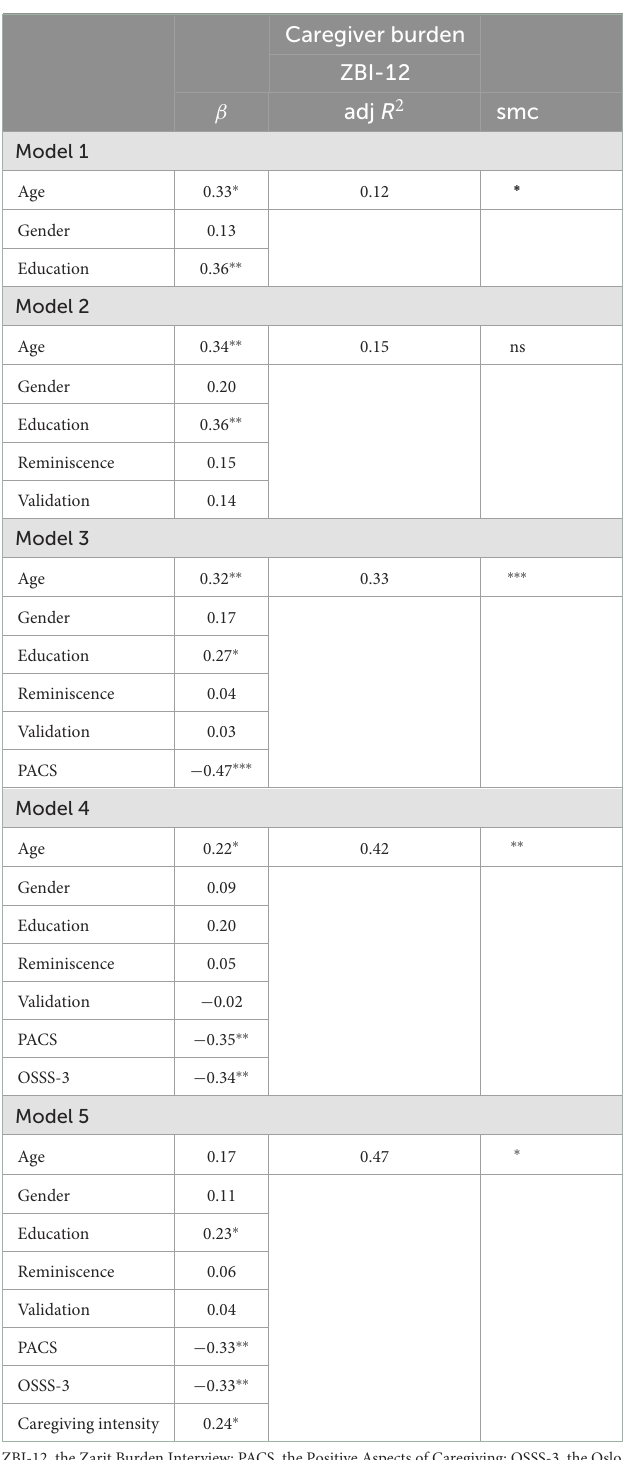
TABLE 5 Linear multiple regression analyses between subjective caregiver burden and socio-demographic characteristics (Model 1), applying therapeutic communication methods (Model 2), caregiving experience (Model 3), social support (Model 4), and caregiving intensity (Model